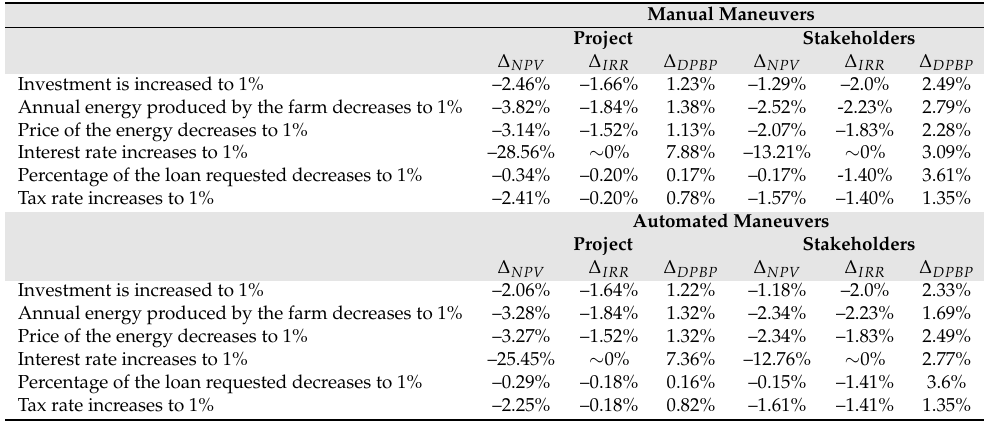
Figure 19. NPV results for the stakeholders when manual and automated maneuvers are carried out. Table 2. Sensitivity analysis results when manual and automated maneuvers are carried